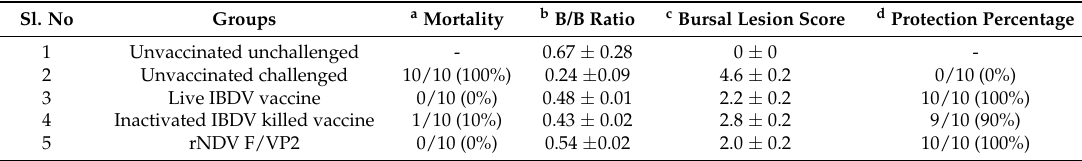
Table 1. Protection efficacy in different groups of chickens against vvIBDV